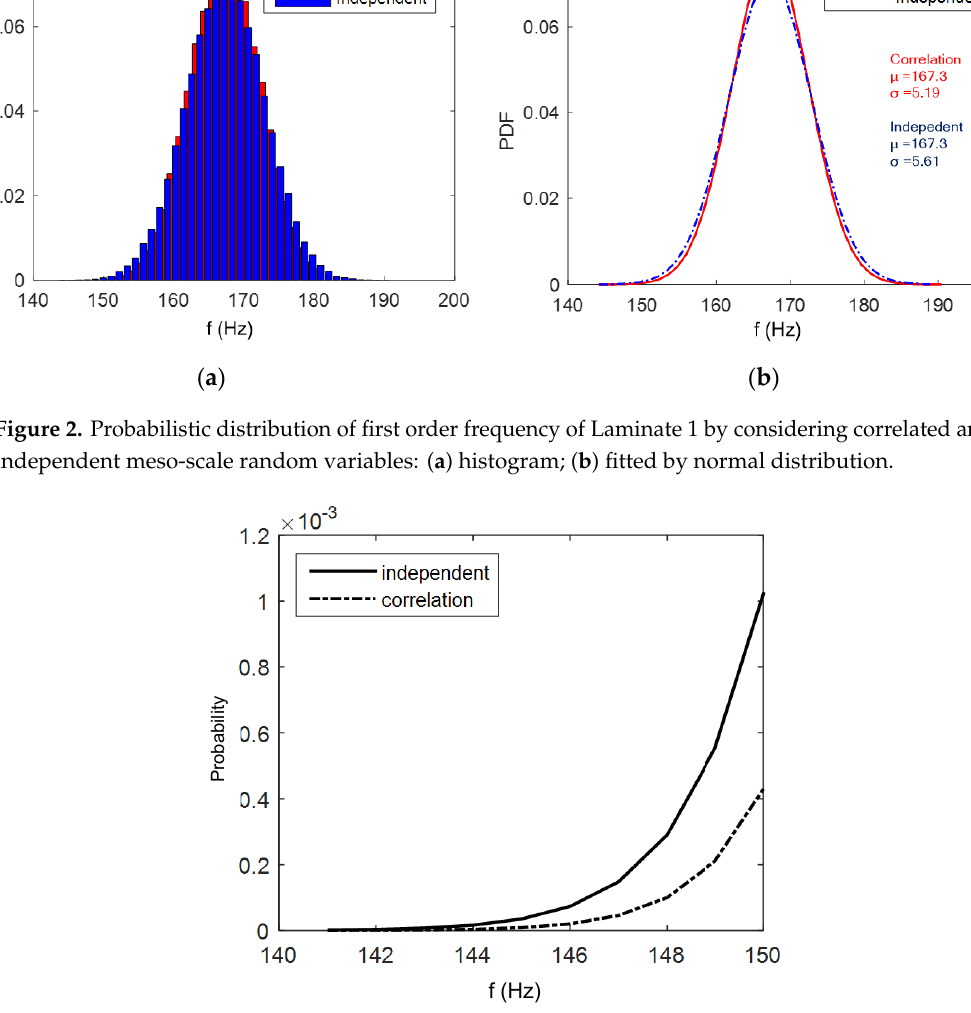
Figure 3. Cumulative probability of first order frequency of Laminate 1, derived by considering correlated and independent meso-scale random variables.